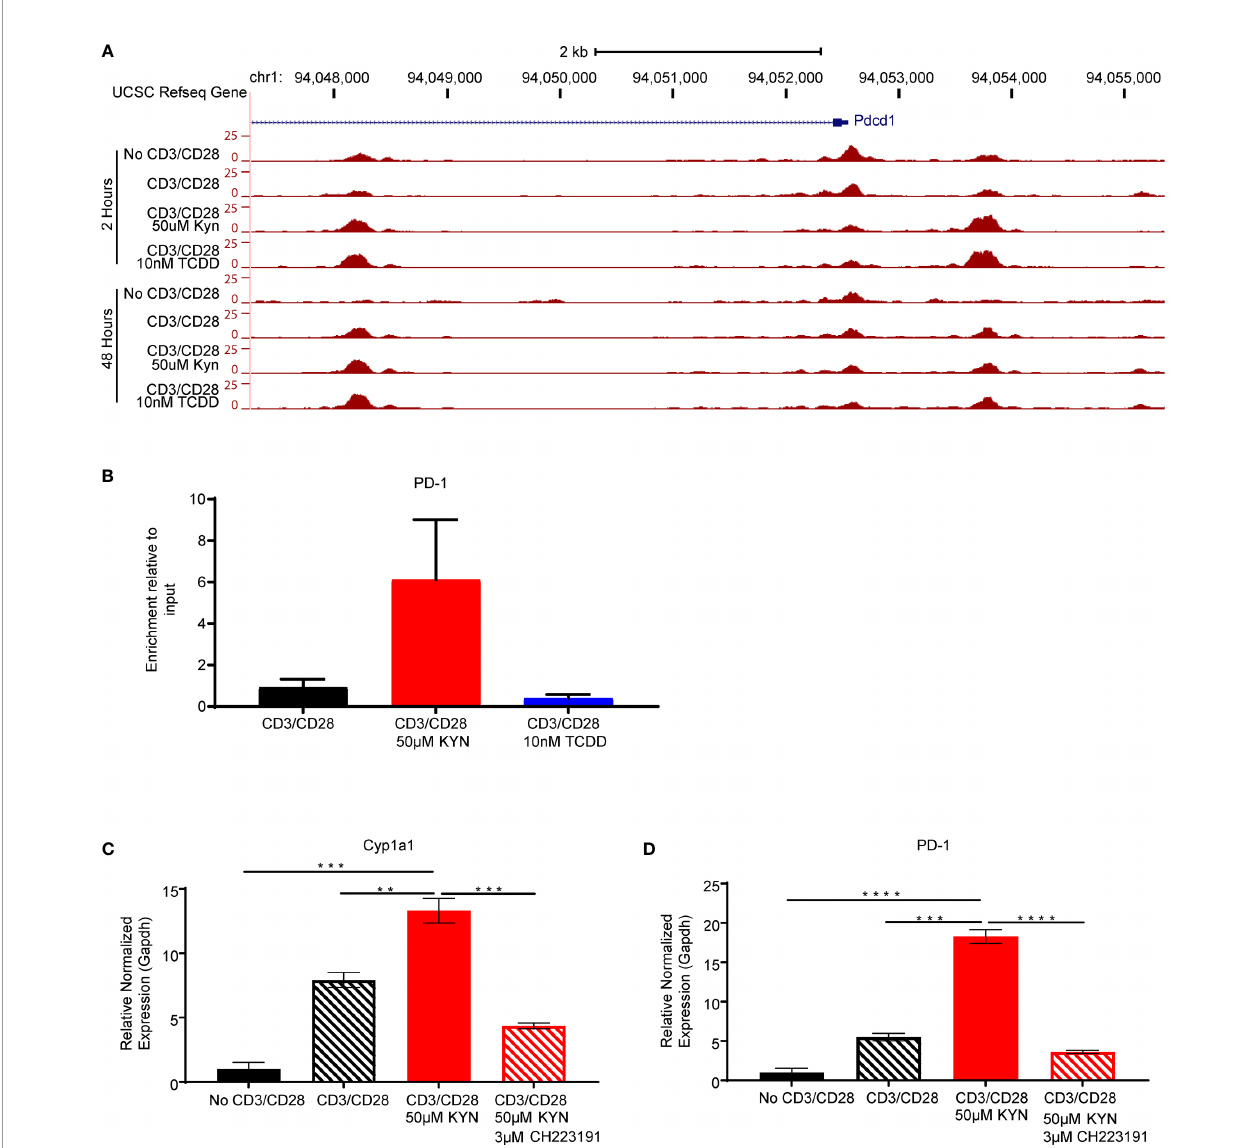
FIGURE 6 | Kynurenine induces PD-1 expression on CD8+ T cells in an AHR-dependent manner. (A) UCSC Genome Browser plot of open chromatin accessible regions in two DNA regulatory elements in the PD1 gene identi fi ed by ATAC-seq analysis of CD8+ T cells, from WT C57BL/6 mice, activated by anti-CD3/CD28 and treated with KYN (50µM) or TCDD (10nM) for 2 and 48 hrs. (B) CHIP-qPCR Pdcd1 analysis in anti-CD3/CD28 bead-activated and KYN (50µM) treated CD8+ T cells for 2 hours from spleens of WT C57BL/6 mice with AHR antibody and pdcd1 promoter primers. (C) Anti-CD3/CD28 activated CD8+ T cells from spleens of WT C57BL/6 mice were treated with KYN (50µM) and CH223191(AHR antagonist) (3 m M) for 6 days. Cyp1a1 and (D) PD-1 mRNA was determined. **p < 0.01, ***p < 0.001, ****p < 0.0001 by Student ’ s t test (B – D) . The data represent means ± SEM of three independent experiments performed in triplicate (B – D)